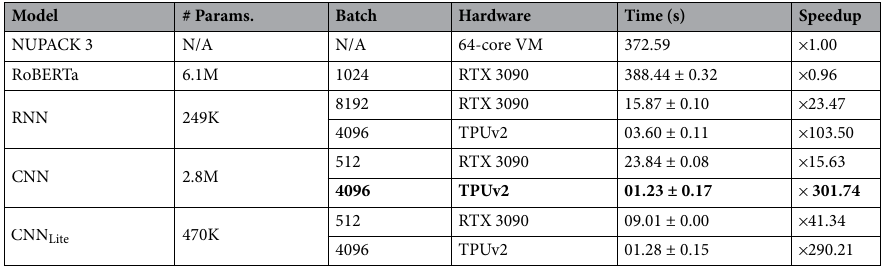
Table 2. The execution of all deep learning methods is timed on the test dataset of 255,701 samples. The text in bold corresponds to the best model according to the time/speedup. The average execution time and the standard deviation are reported in seconds. Each deep learning method is run 10 times, after an initial warm-up run. The time elapsed to load the dataset into memory is not taken into account and the batch size was chosen to maximise inference time. All deep learning models use consumer hardware or openly-available hardware (the TPU platform is completely free to